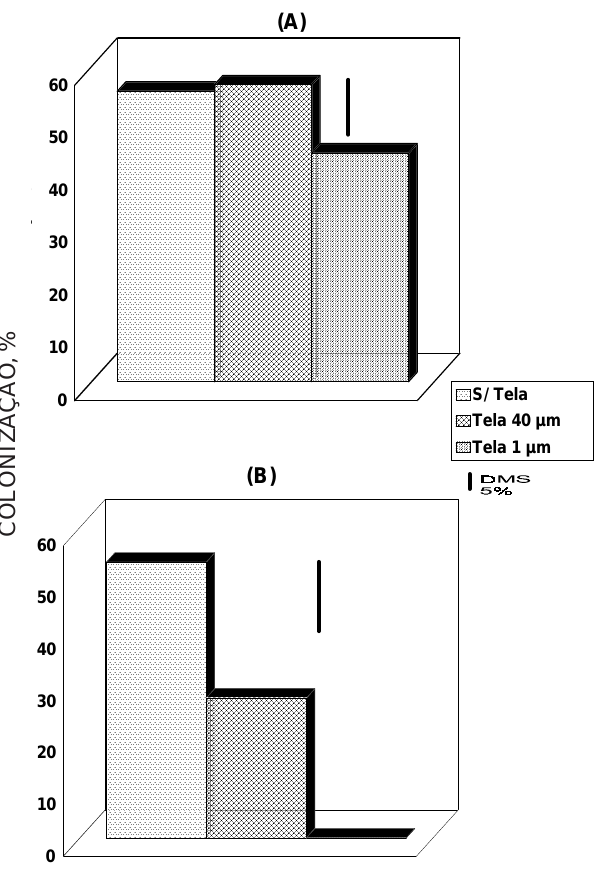
Figura 2. Colonização micorrízica das raízes de milho (A) e feijão (B), inoculadas com Glomus etunicatum , nos vasos com tela de 1 µm, 40 µm e sem